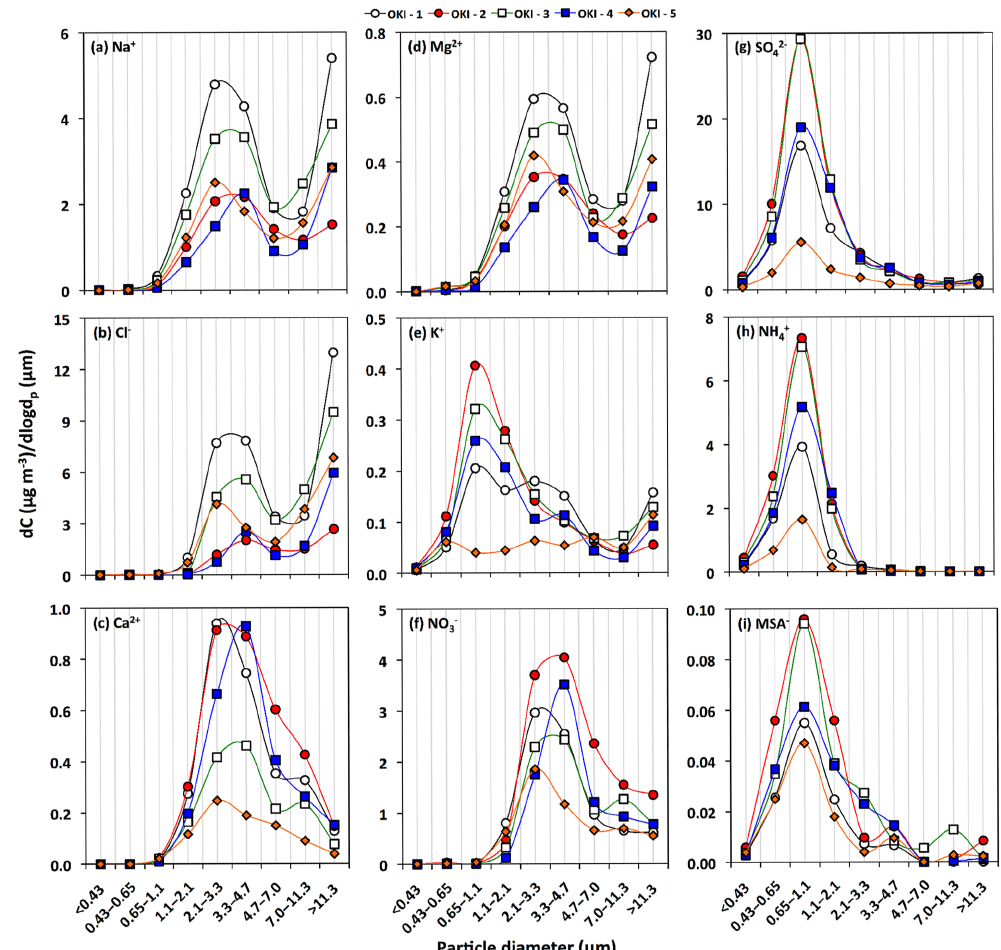
Figure 4. Size distributions of water-soluble inorganic ions in the aerosol samples collected on Okinawa